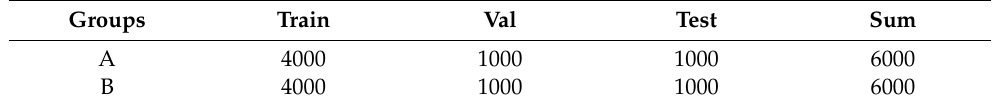
Table 3. Classification of the experimental